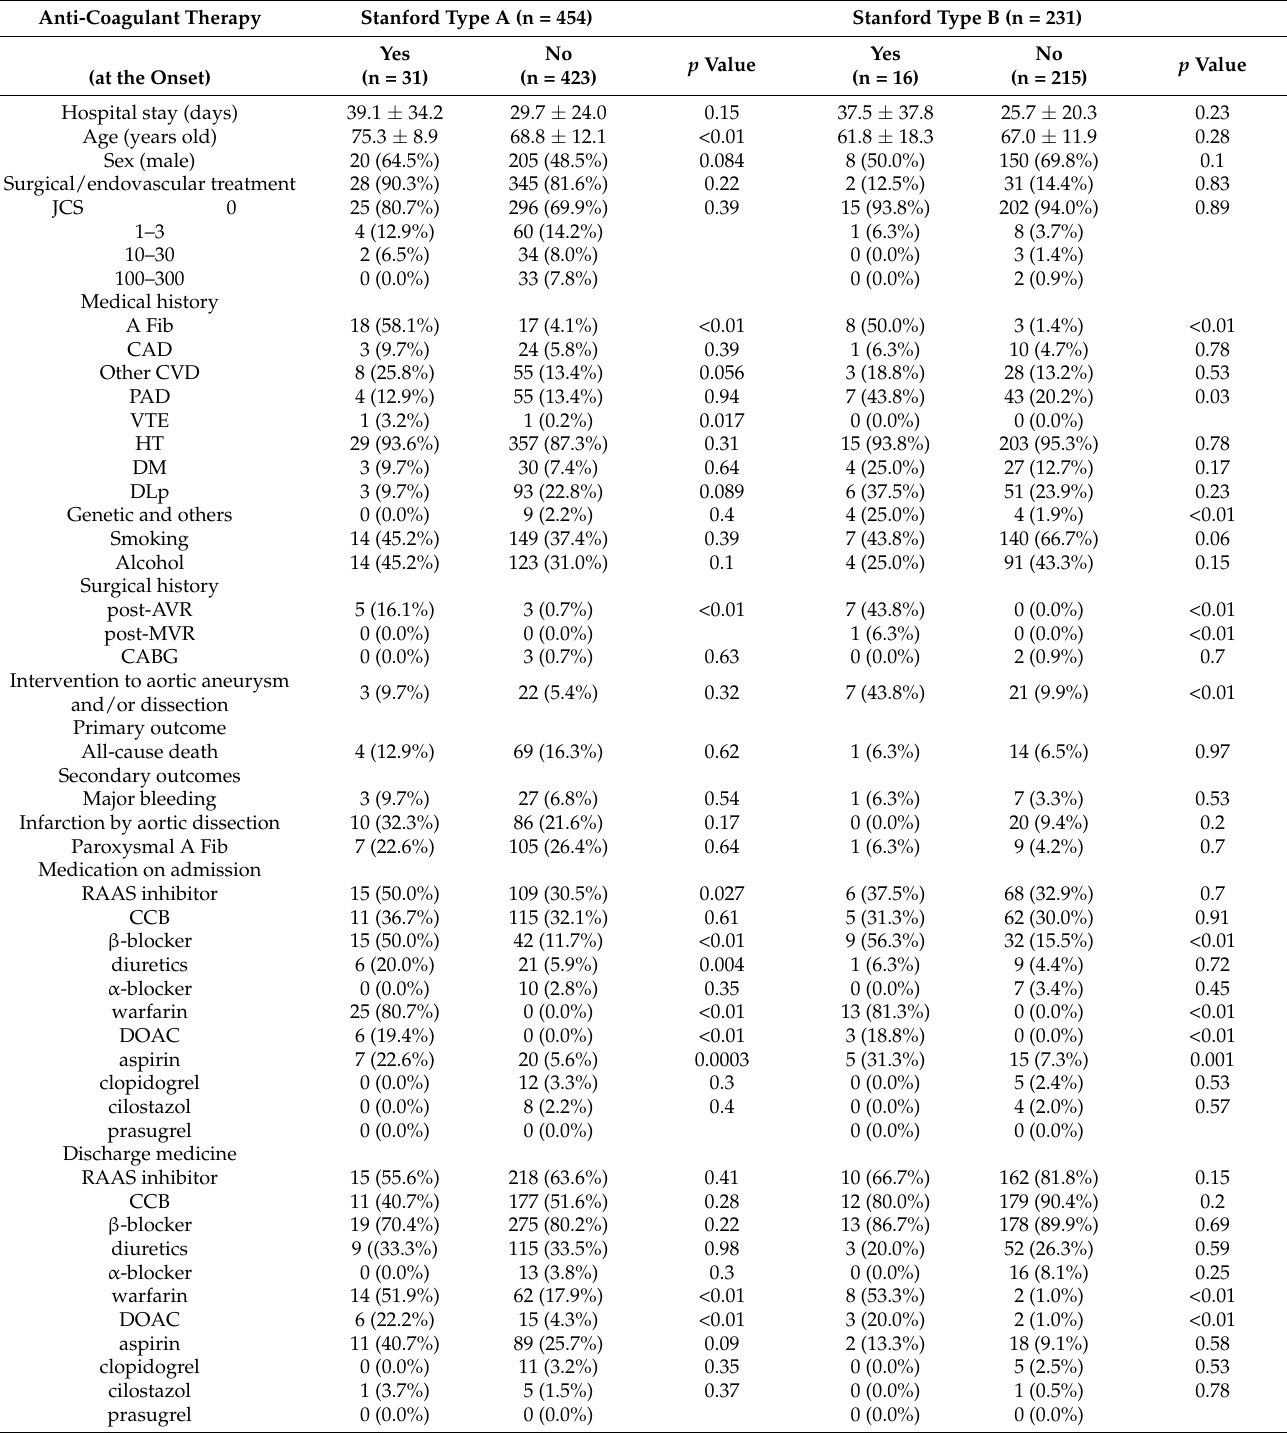
Table 2. Clinical characteristics of TRANSFERRED acute aortic dissection patients with and without anti-coagulant